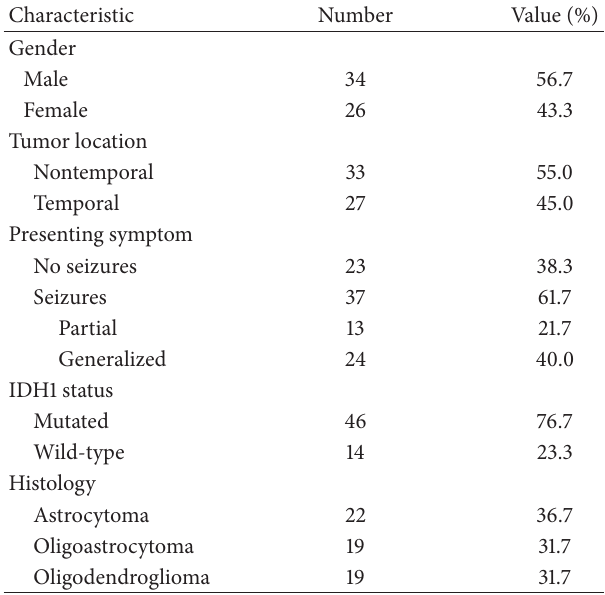
Table 1: Clinical information of patients ( 𝑛 = 60 ).